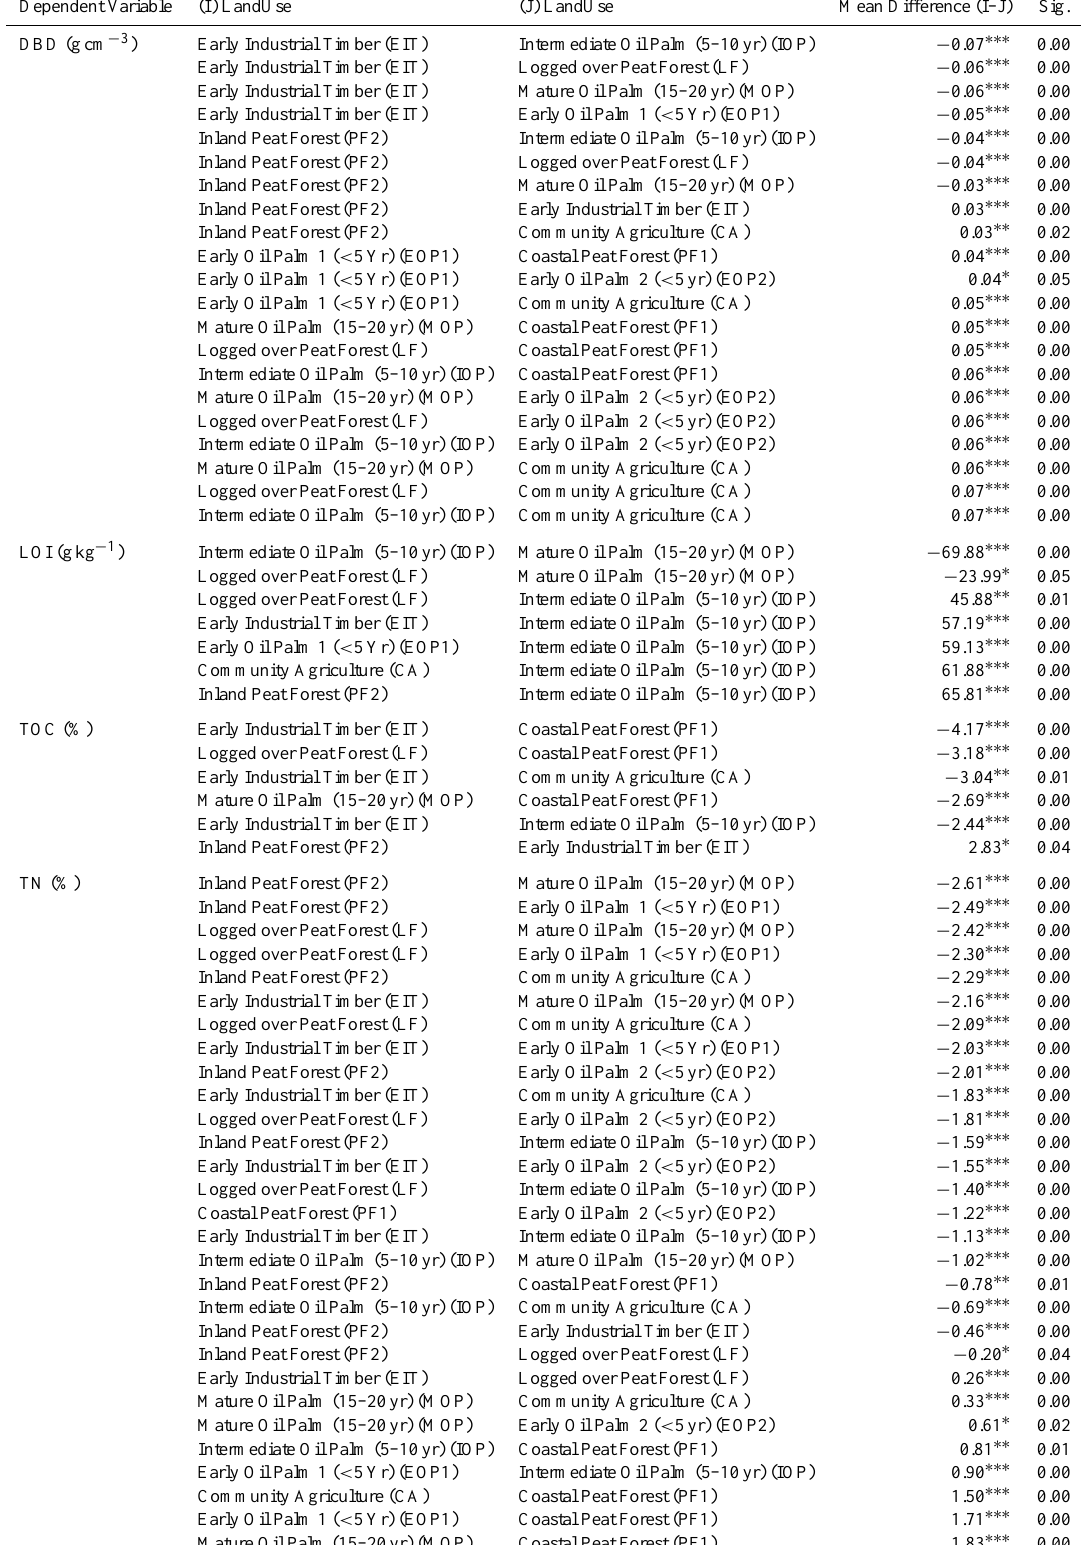
Table 15. Games-Howell Multiple Comparisons of DBD, LOI TOC, TN, and Atomic C/N Ratio according to Land Use Groups. Dependent